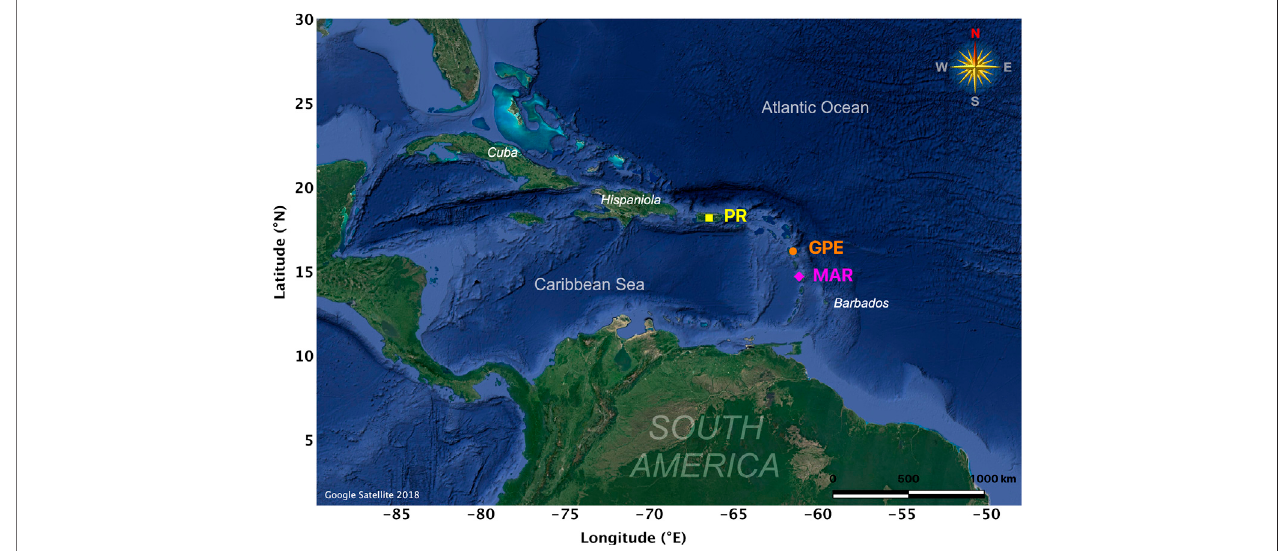
FIGURE1 | Overview oftheCaribbean area with Puerto-Rico at thetop (18.23 ° N,66.50 ° W; PRin yellow) and Guadeloupearchipelago(16.25 ° N, 61.58 ° W;GPE in orange) then Martinique (14.66 ° N, 61.01 ° W; MAR in purple) in the middle.